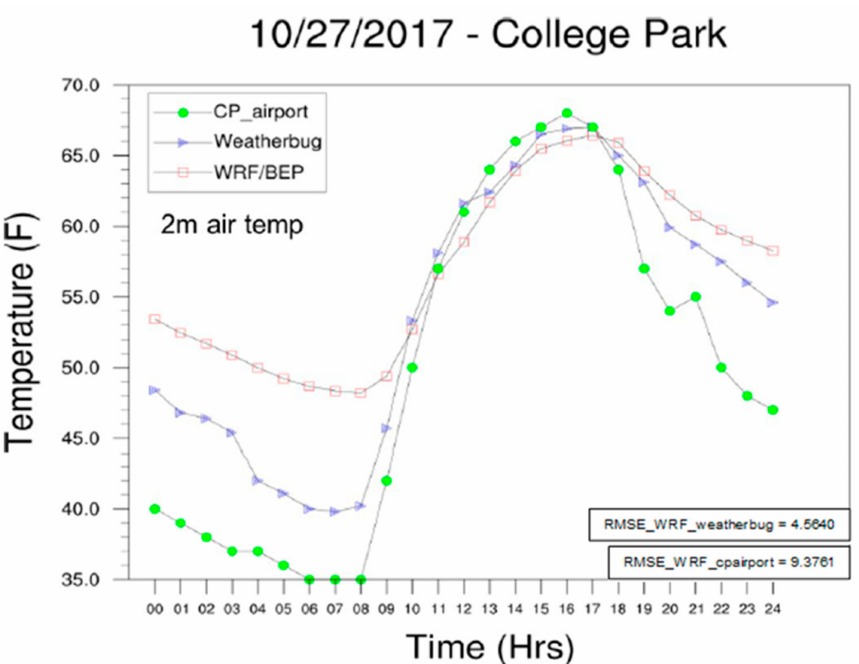
Figure 1. Two-meter air temperature observed at the WeatherBug site (“Weatherbug”) on one building’s roof of University of Maryland, College Park, College Park airport (“CP_airport”) and original weather research and forecasting (WRF) / building environment parameterization scheme (BEP) model simulation (“WRF / BEP”) for 10 / 27 /